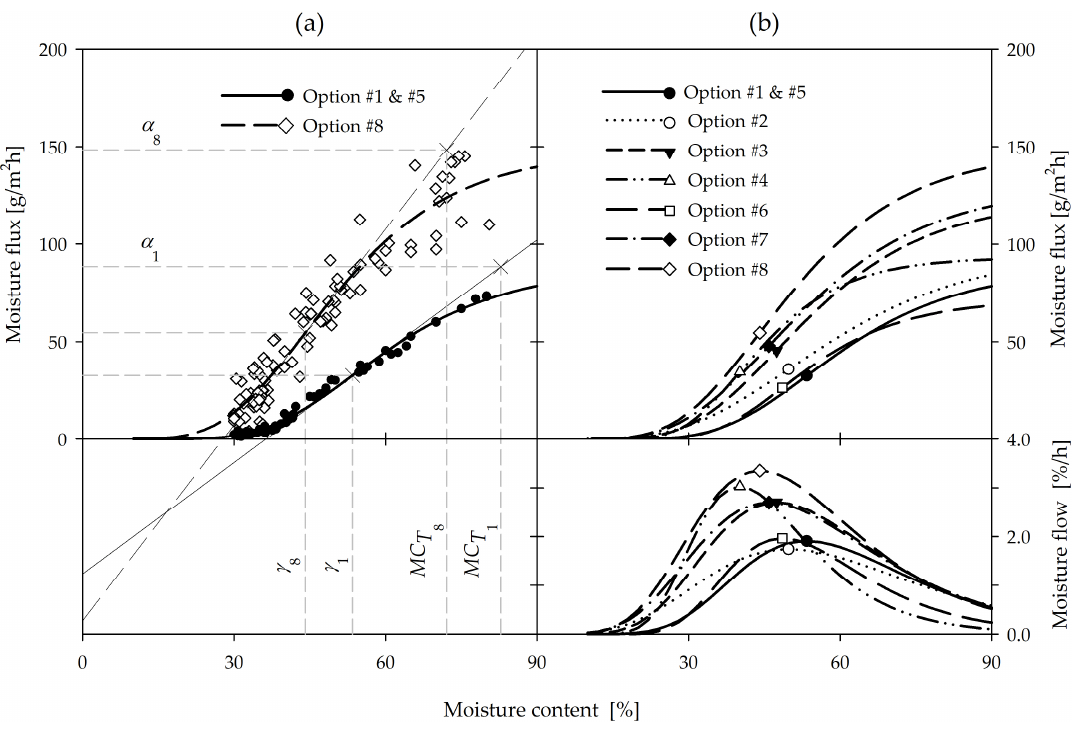
Table 4. Experimental (input) data for the response surface methodology (RSM) model.